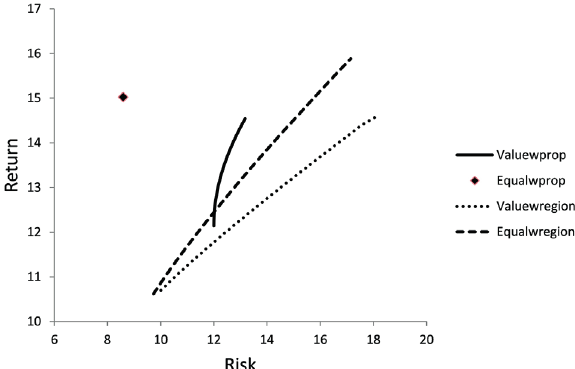
fig. 1. The efficient frontier for equal- and value-weighted portfolios